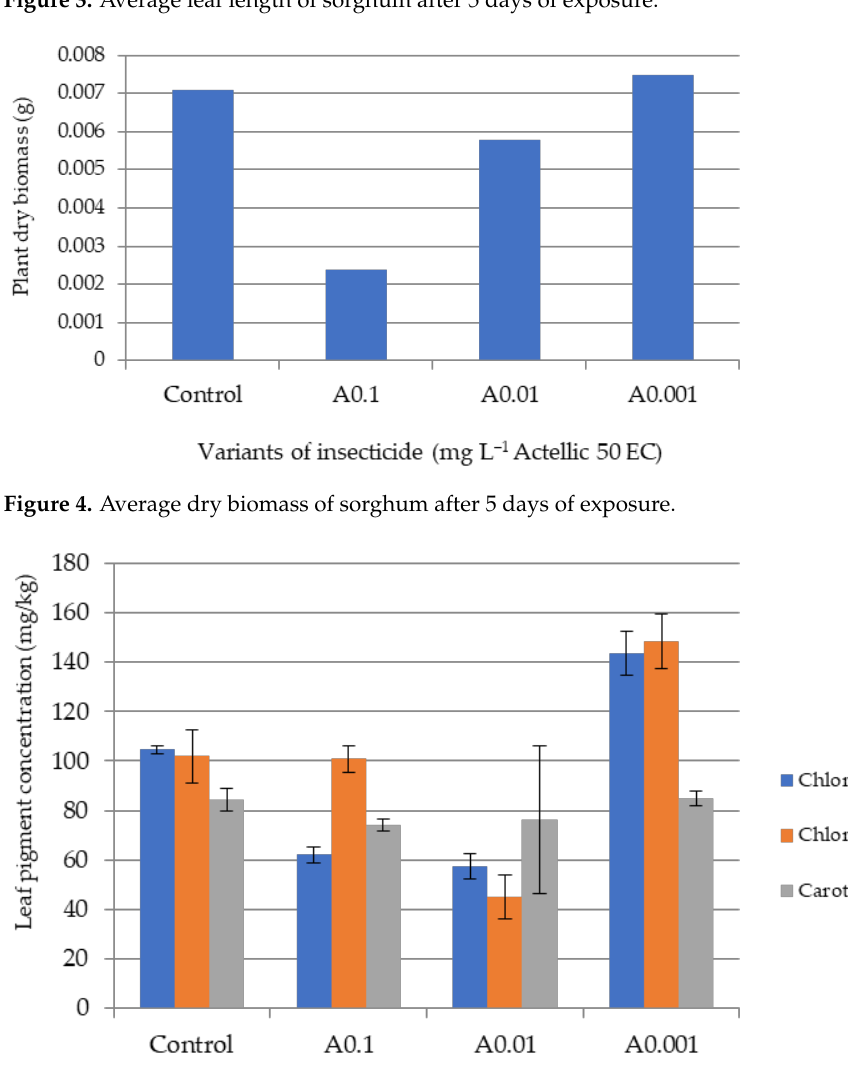
Figure 5. Average concentration of foliar pigments in sorghum plants after 5 days of